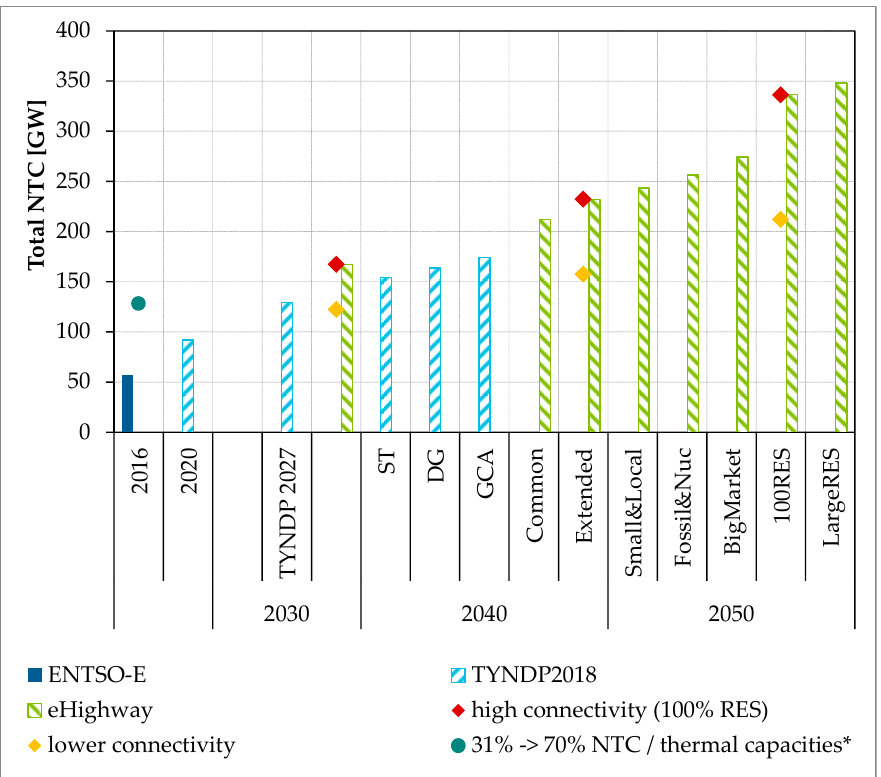
Figure 6. Development of total NTC in the ENTSO-E area [5,29]. *Increase of the NTCs due to a higher NTC to thermal grid capacity ratio: 2016: Ø 31% [38], 2025: min. 70% [39].